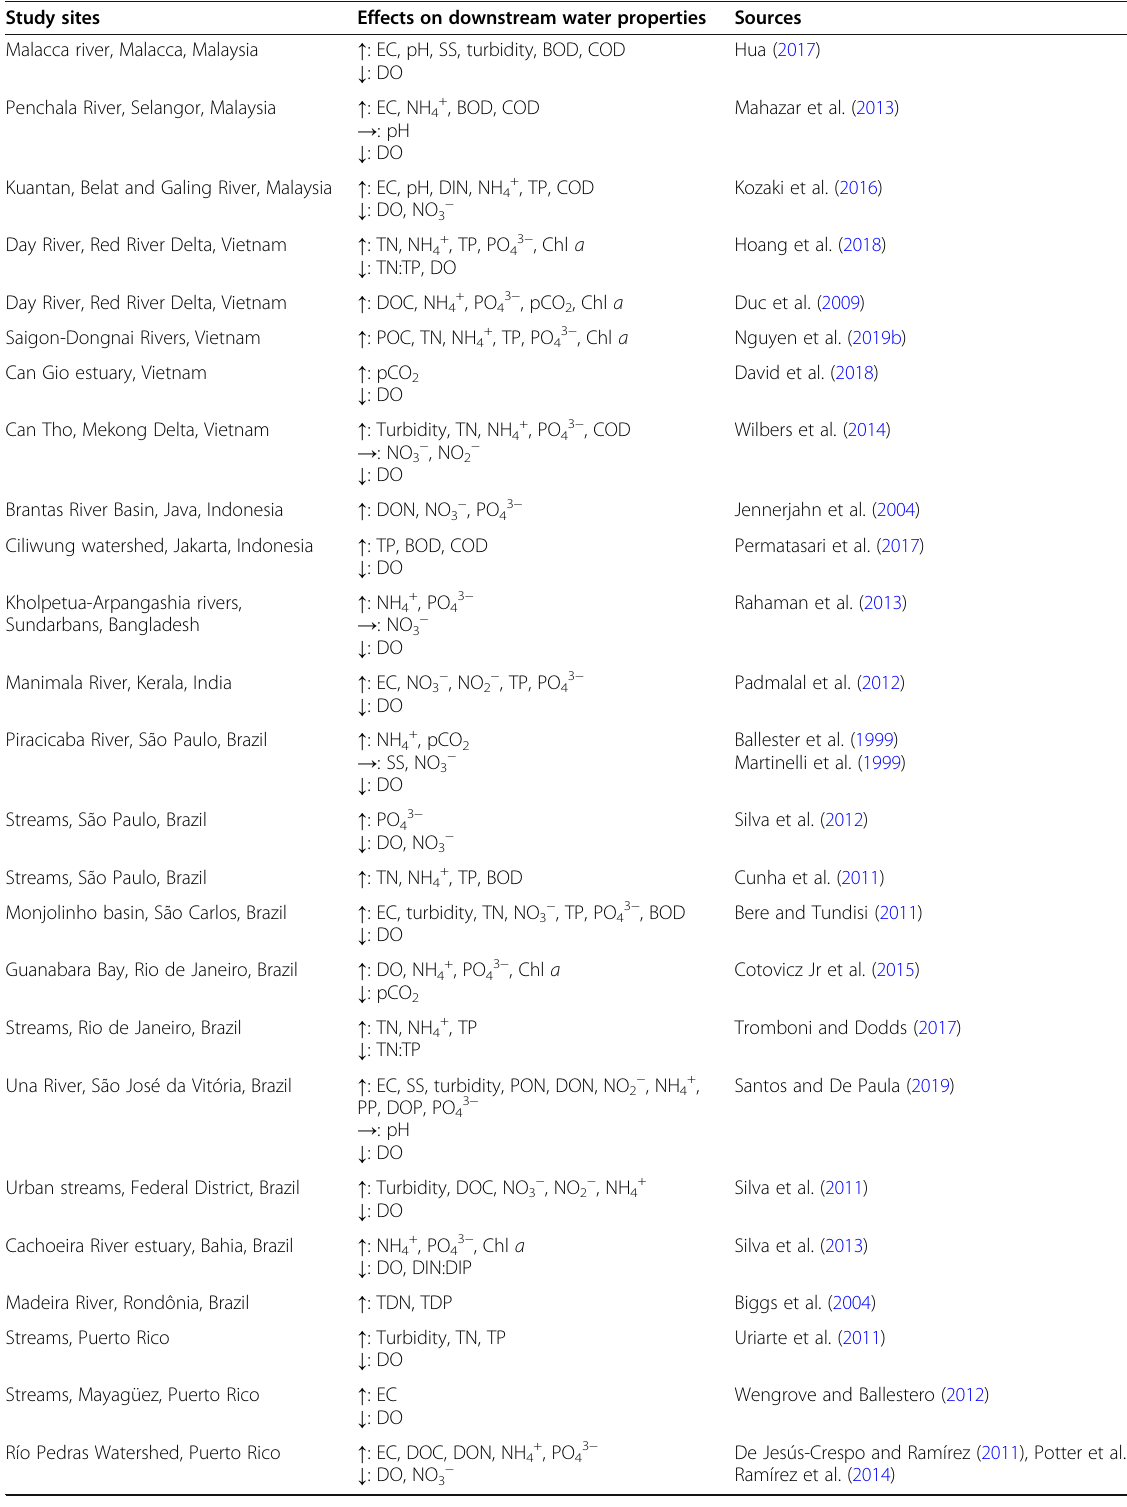
Table 7 A summary of the effects of urbanization on the downstream riverine and estuarine water properties. When most minerals (e.g., Na + , Mg 2+ , Cl − , K + , Ca 2+ ) increased, they were collectively described as EC increased. The arrows before the water properties indicate that the subsequent water properties increased ( ↑ ), decreased ( ↓ ), or did not change ( → ). See the list of abbreviations for the water